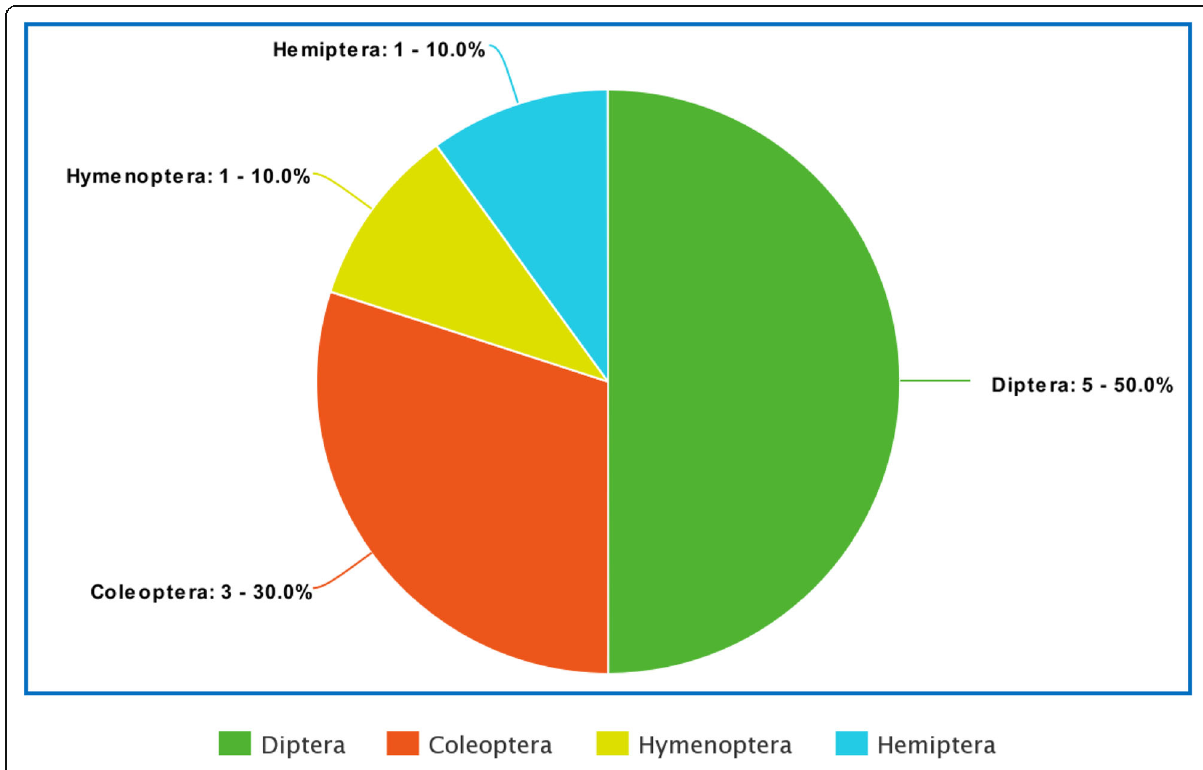
Fig. 3 Pie-chart showing number of insects species collected per